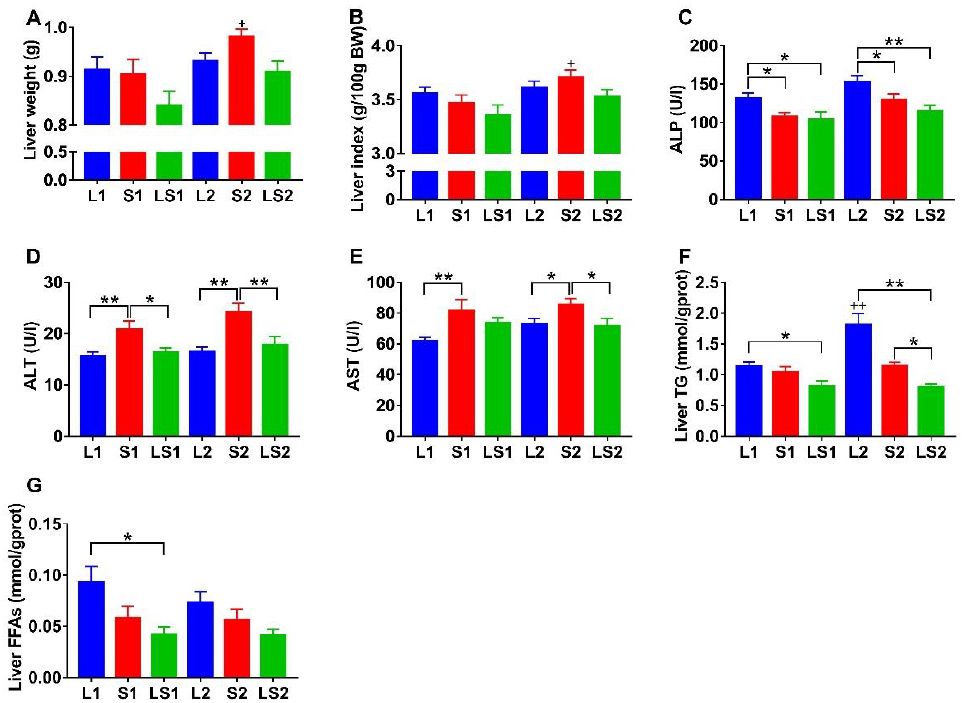
Figure 4. Impacts of various oil/fat diets on ( A ) liver weight, ( B ) liver index, ( C ) alkaline phosphatase (ALP), ( D ) alanine aminotransferase (ALT), ( E ) aspartate aminotransferase (AST), ( F ) liver TG, ( G ) liver FFAs in mice during a period of 16-week intervention. Liver weight and liver FFAs were analyzed using Kruskal–Wallis, significance was determined by two-tailed unpaired t test, p value was adjusted using Bonferroni. “*” represents significant differences at p < 0.05; “**” denotes considerable differences at p < 0.01; “+” implies marked variations at p < 0.05 relative to the same oil type with different energy level; “++” represents significant differences at p < 0.01 relative to the same oil type with different energy